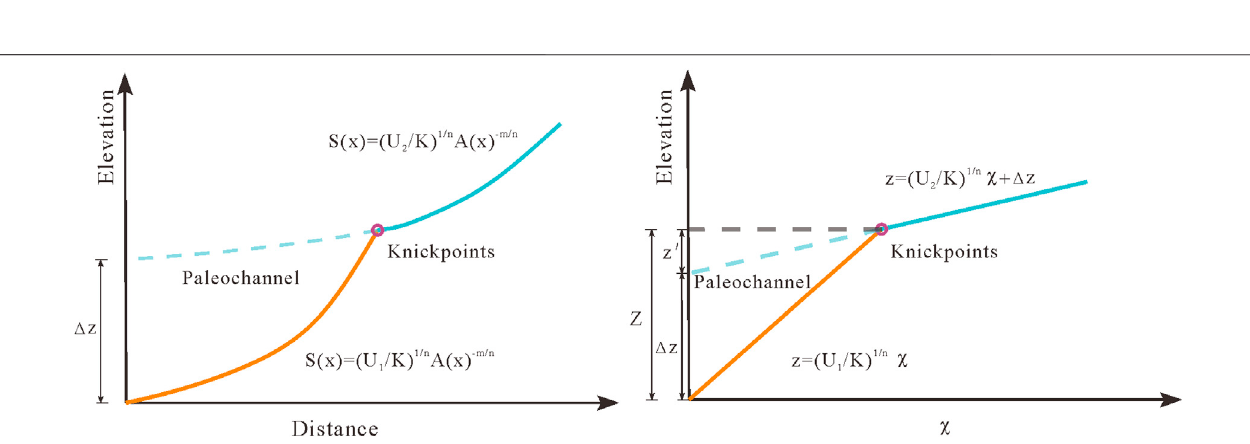
FIGURE 3 | Paleochannel reconstruction in two coordinate systems [modi fi ed from Kirby and Whipple, (2012)].